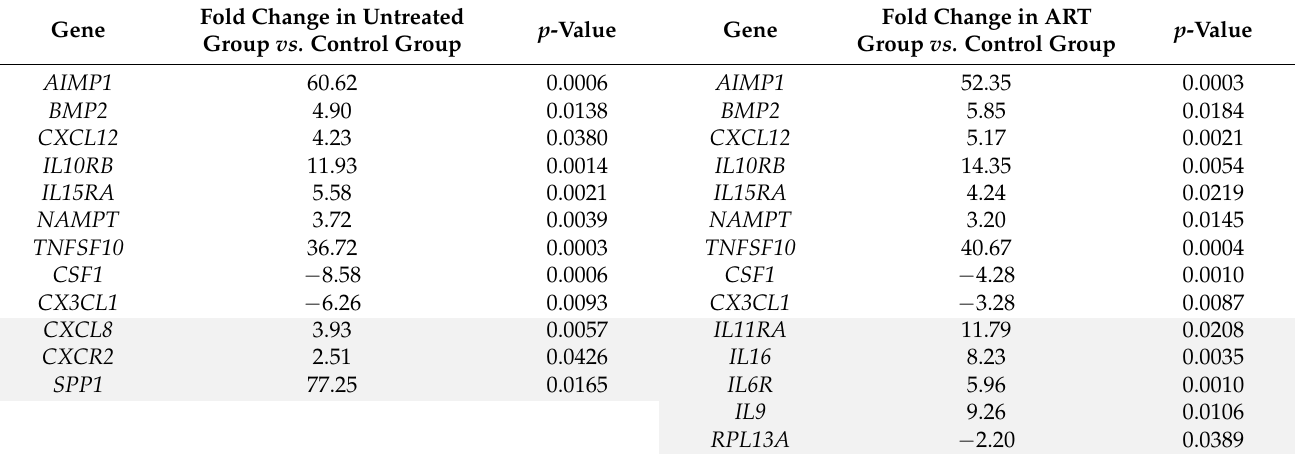
Table 1. Gene expression fold change and p -value for each experimental group against the control